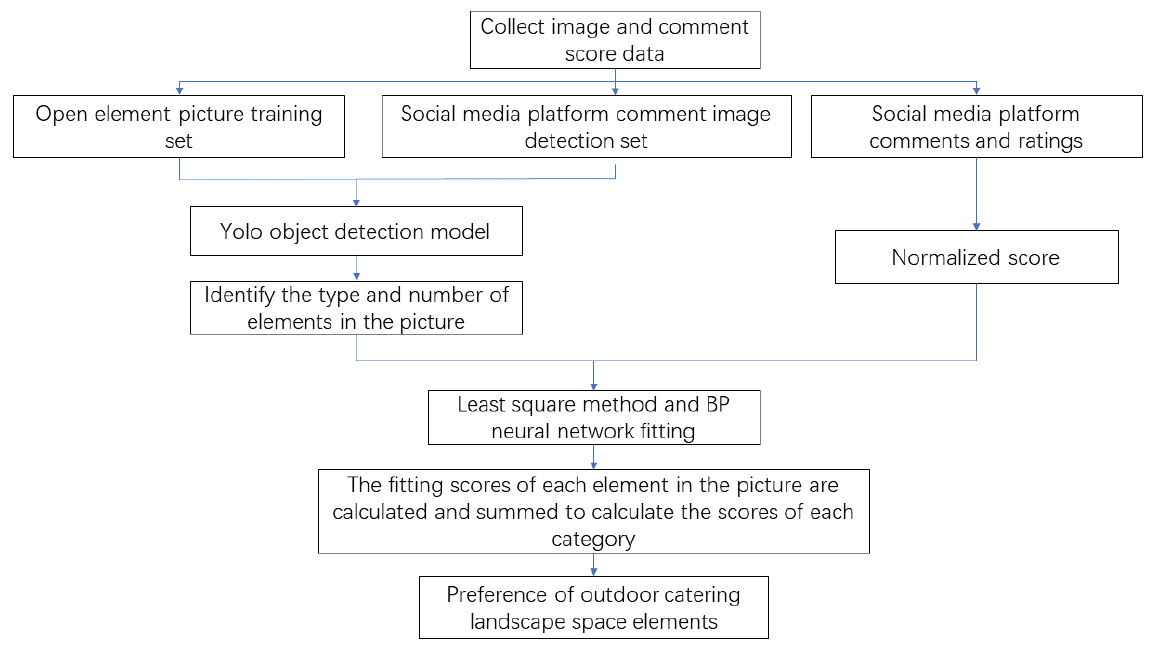
Figure 3. Research